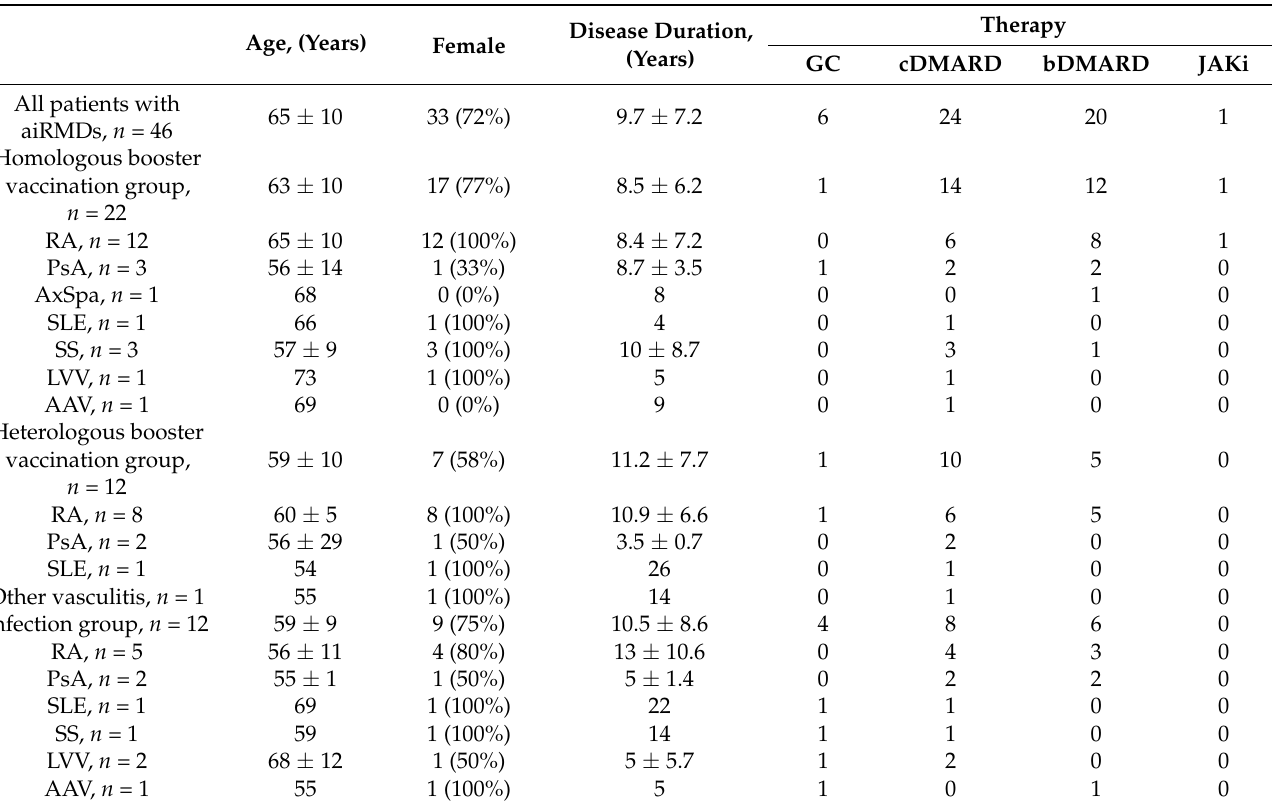
Table 2 Data are presented as mean ± SD or n (%). AAV, antineutrophil cytoplasmic antibody (ANCA)-associated vasculitis; aiRMD, autoimmune and inflammatory rheumatic and musculoskeletal disease; AxSpA, axial spondyloarthritis; LVV, large vessel vasculitis; PsA, psoriatic arthritis; RA, rheumatoid arthritis; SLE, systemic lupus erythematosus, SS, Sjögren syndrome; GC, glucocorticoids; cDMARD, conventional DMARD including methotrexate, leflunomide, azathioprine, chloroquine, cyclosporine, hidroxychloroquine; bDMARD, biological DMARD including tumor necrosis factor alpha inhibitors (10 patients with RA and 1 patient with AxSpa and 1 patient with PsA), interleukin 17 inhibitors (2 patients with PsA and 2 patients with AxSpa), interleukin 6 inhibitors (4 patients with RA); JAKi, janus kinase